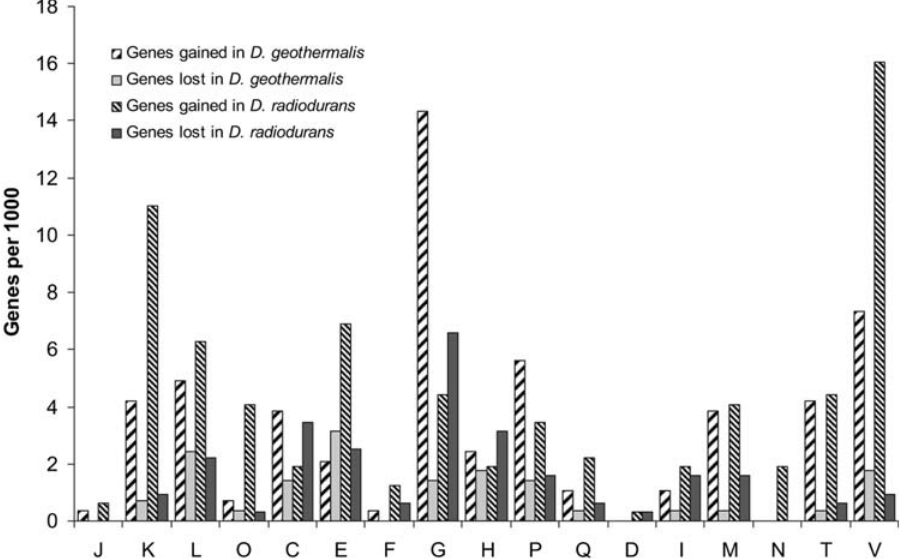
Figure 3. Gene-gain and gene-loss for different functional groups for D.radioduransand D.geothermalis. Designations of functional groups (from the COG database): J–Translation, ribosomal structure and biogenesis; K–Transcription; L–DNA replication, recombination and repair; D–Cell division and chromosome partitioning; O–Posttranslational modification, protein turnover, chaperones; M–Cell envelope and outer membrane biogenesis; N–Cell motility and secretion; P–Inorganic ion transport and metabolism; T–Signal transduction mechanisms; C–Energy production and conversion; G–Carbohydrate transport and metabolism; E–Amino acid transport and metabolism; F–Nucleotide transport and metabolism; H– Coenzyme metabolism; I–Lipid metabolism; Q–Secondary metabolites biosynthesis, transport and catabolism; V–genes involved in stress response and microbial defense. doi:10.1371/journal.pone.0000955.g003 PLoS ONE |